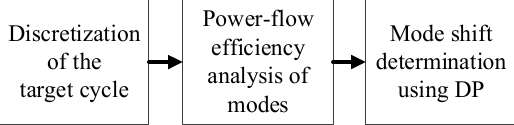
Figure 12. Enhanced power-weighted efficiency analysis for rapid sizing (E-PEARS+) process.